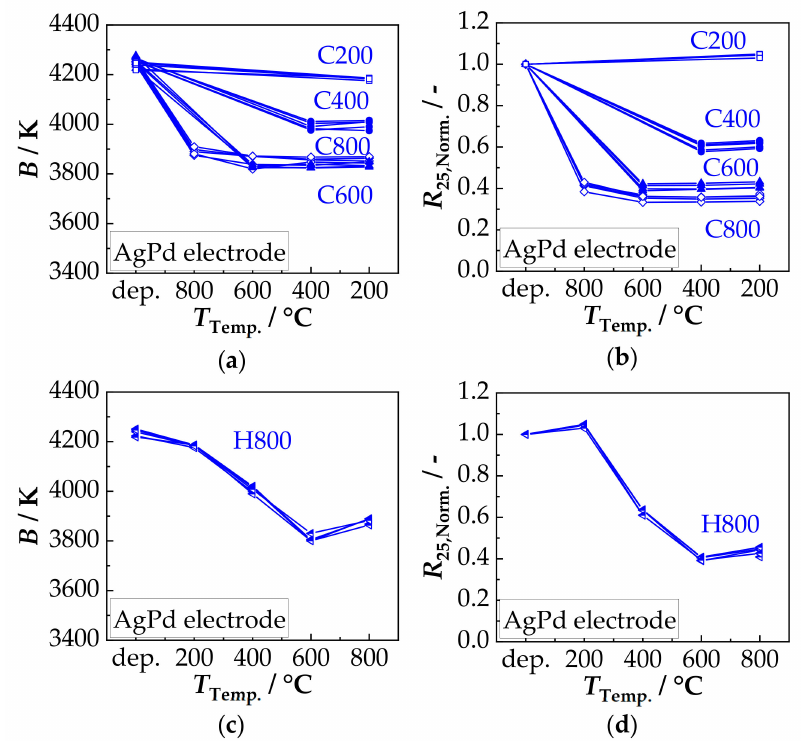
Figure 6. AgPd electrode: Tempering-related change of ( a ) B and ( b ) R 25,Norm. in the as-deposited state (dep.) and after cycles C800, C600, C400, and C200, respectively, and of ( c ) B and ( d ) R 25,Norm. in the as-deposited state and after cycle